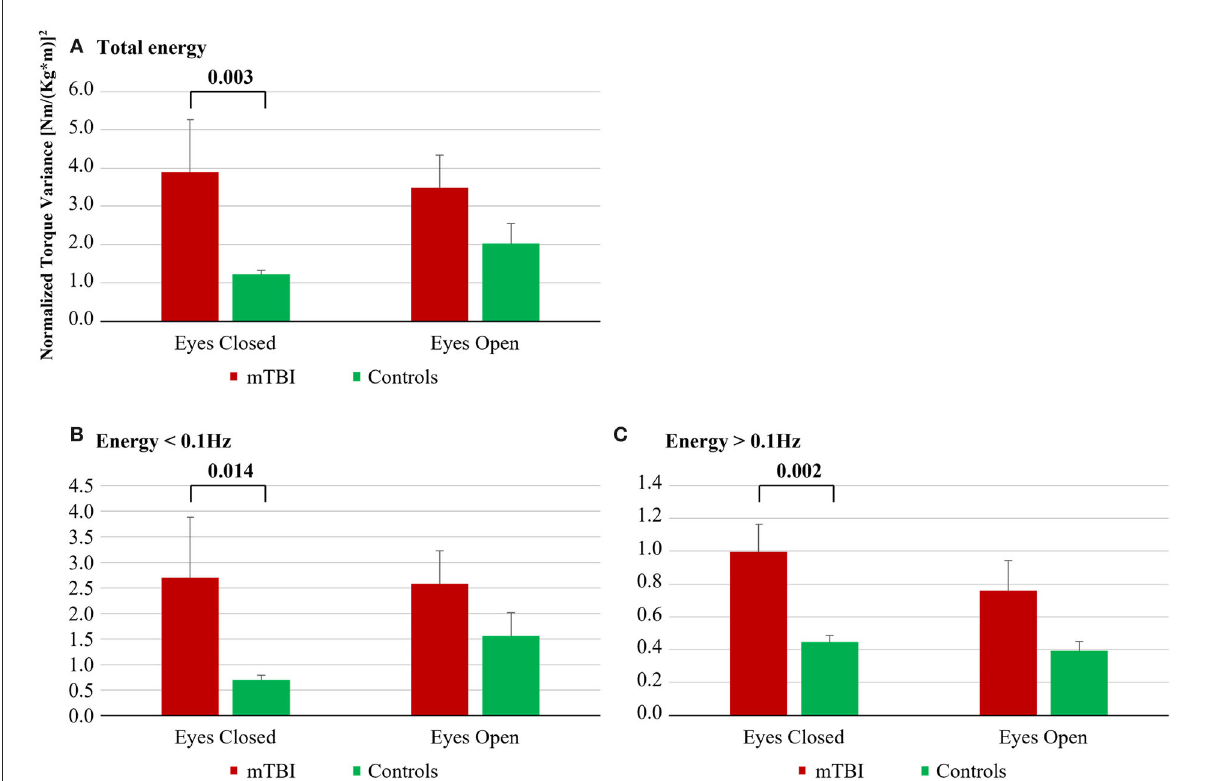
FIGURE2 Energy used by mTBI subjects and by controls during the quiet stance tests; (A) Total energy; (B) Energy < 0.1Hz; (C) Energy >